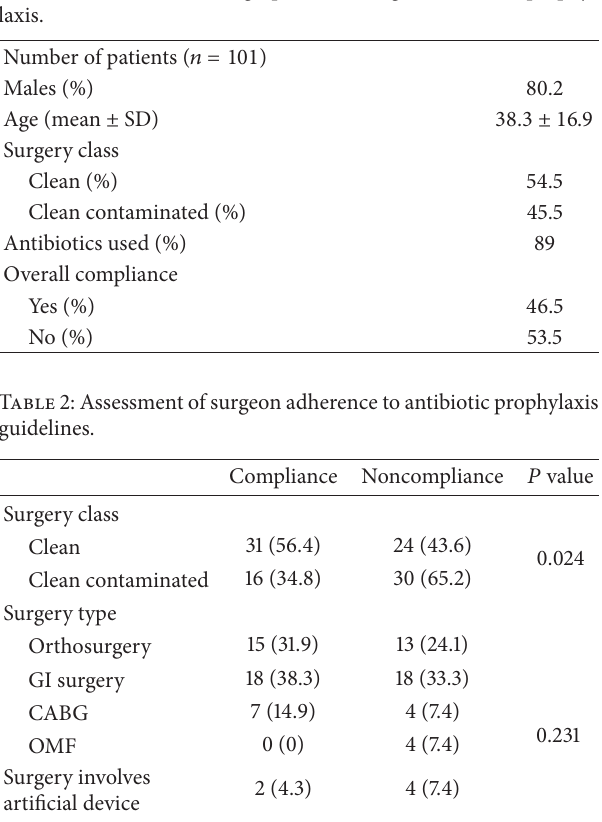
Figure 3: Reasons for